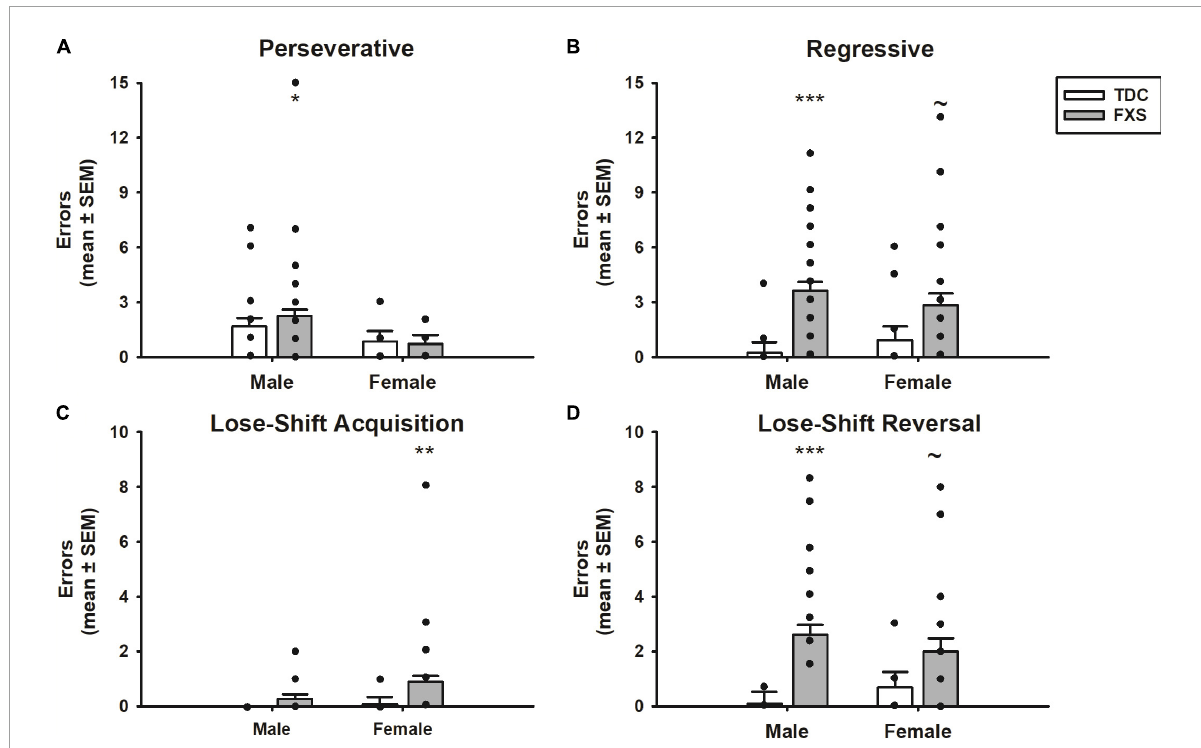
FIGURE4 Error committed during reversal learning of a spatial discrimination (80/20 probabilistic learning procedure). (A) Mean ( ± SEM) perseverative errors during reversal learning. Fragile X syndrome (FXS) and TDC subjects did not differ in the number of perseverative errors. However, males with FXS made more perseverative errors than their TDC counterparts. (B) Mean ( ± SEM) regressive errors during reversal learning. FXS participants committed more regressive errors compared to controls during reversal learning. This finding was significant comparing male groups, but only trending when comparing female groups. (C) Mean ( ± SEM) lose-shift errors during acquisition. FXS participants made more lost-shift errors, which was driven by females. (D) Mean ( ± SEM) lose-shift errors during reversal learning. Males with FXS committed more lose-shift errors than TDC males, a finding that was only trending among females. * p < 0.05 vs. TDC males; ** p < 0.05 vs. TDC females; *** p < 0.001 vs. TDC males; ∼ p < 0.10 vs. TDC females. Solid dot indicates individual participant data point.